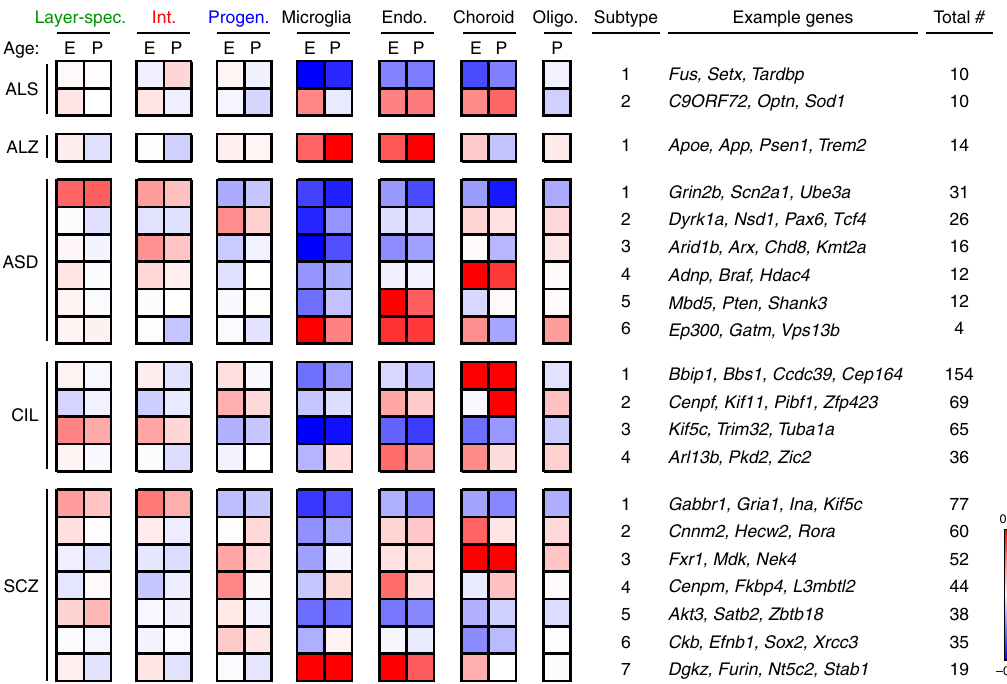
Fig. 5 Identi fi cation of putative disease subtypes using hierarchical clustering. Normalized expression values for genes linked to ALS, Alzheimer ’ s disease (ALZ), autism spectrum disorders (ASD), ciliopathies (CIL), and schizophrenia (SCZ) are summarized by collapsing cell types (using median) into their broader categories (colored); non-neuronal types were not collapsed. Full datasets showing expression of each gene in each cell type is provided in Supplementary Materials. Median-centered normalized expression values are depicted from blue ( – 0.25) to white (0.0) to red